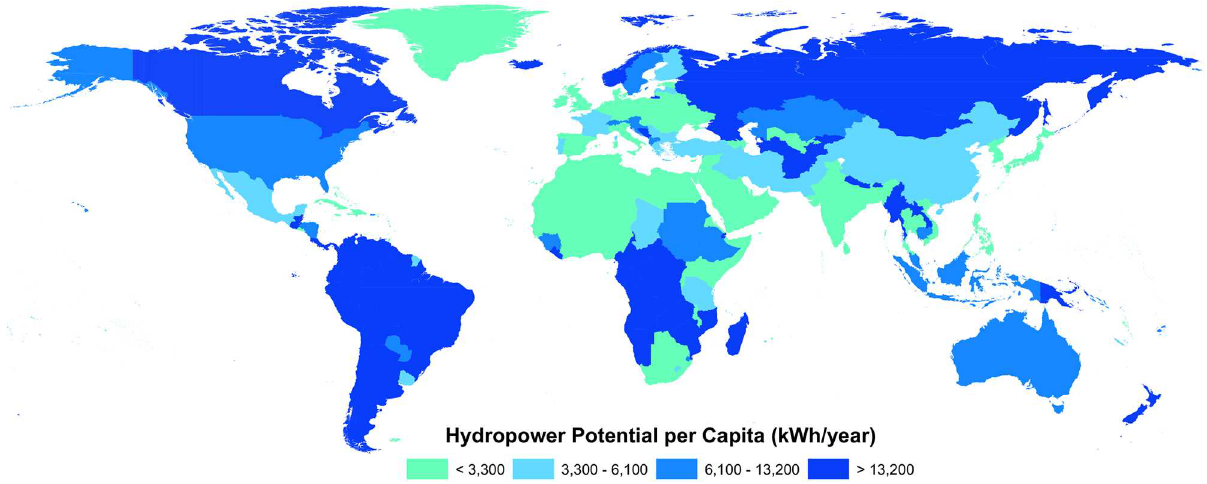
Fig 2. Global map of hydropower per capita per country. The cut-off values correspondto present per capita energyproductionin China (3300 kWh/year), Europe (6100 kWh/year, and the USA (13,200 kWh/year).